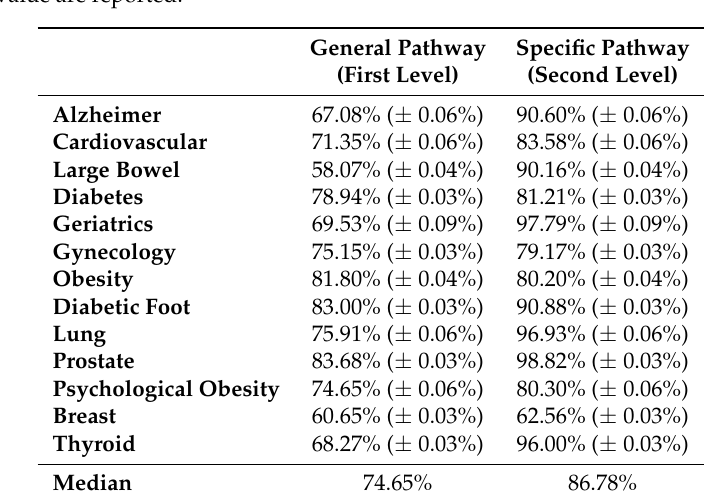
Table 2. Classification performance of the general and specific pathway evaluation (first level) per each disease in the dataset. The performances are in terms of area under the ROC (receiver operating characteristic) curve (AUC–ROC) obtained from a 10-fold cross validation. 95% confidence intervals and median value are